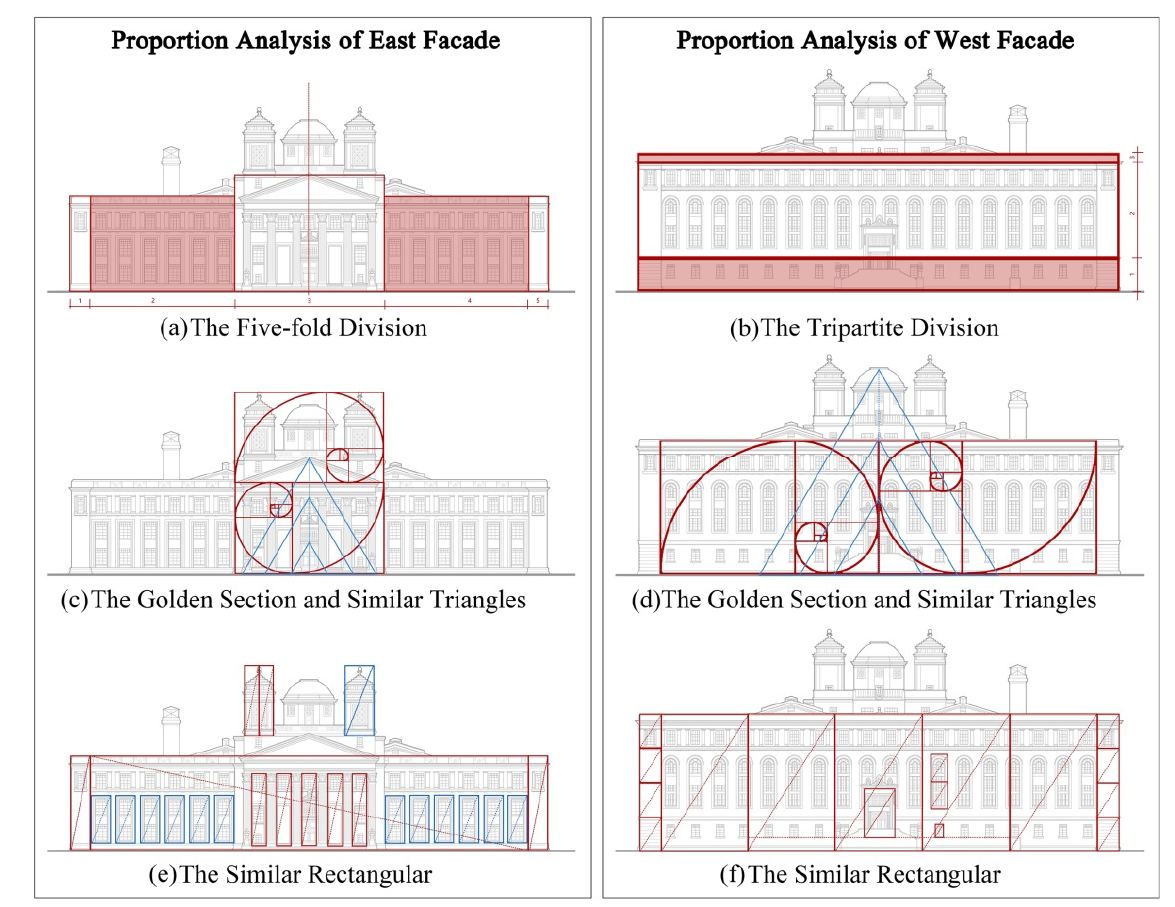
Figure 13. Proportion Analysis of East and West Facades.